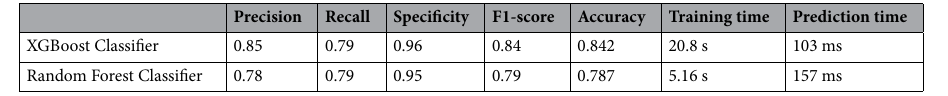
Table 4. Comparison of models’ performance.